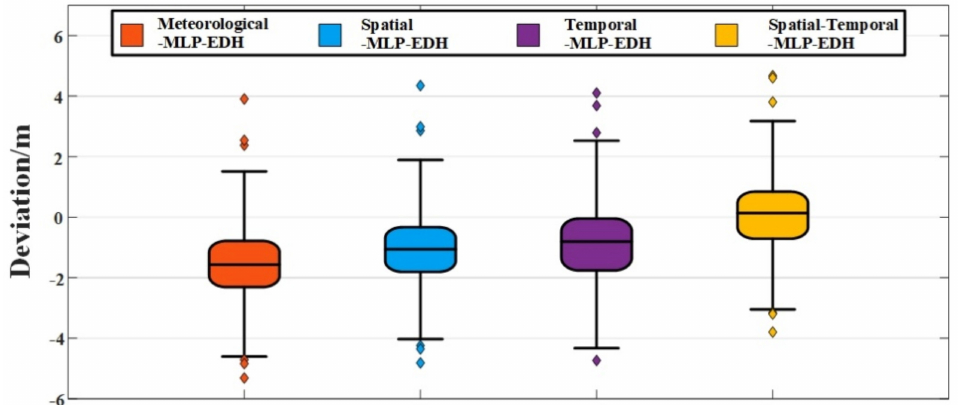
Figure 7. Statistical results of EDH prediction models based on